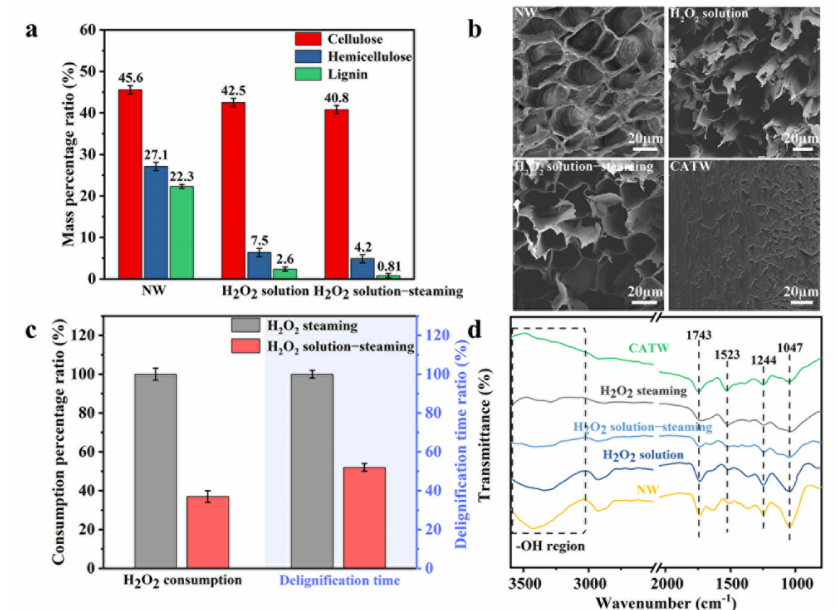
Figure 1. ( a ) Cellulose, hemicellulose, and lignin contents of natural wood (–NW), H 2 O 2 solution bleached wood, and H 2 O 2 solution steaming bleached wood. ( b ) SEM images of NW, H 2 O 2 solution bleached wood, H 2 O 2 solution steaming bleached wood, and CATW. ( c ) Consumption percentage ratio and delignification time ratio determined for the H 2 O 2 steaming method and the H 2 O 2 solution steaming method. ( d ) FTIR spectra of NW, H 2 O 2 solution bleached wood, H 2 O 2 solution steaming bleached wood, H 2 O 2 steaming method bleached wood, and